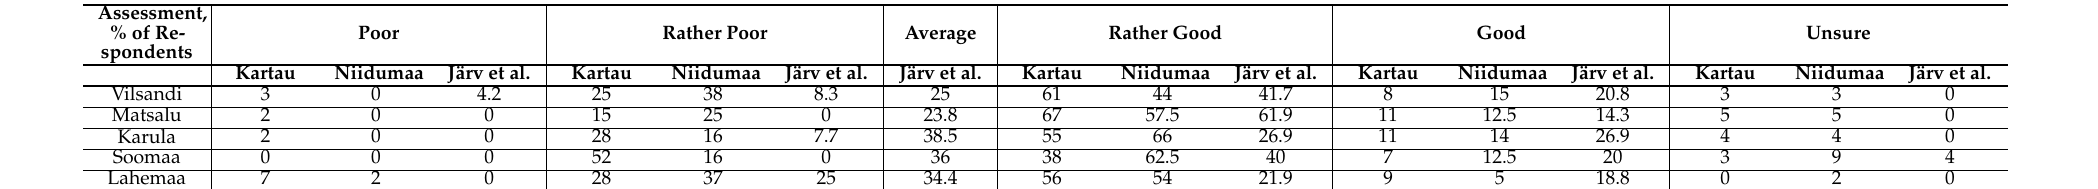
Table 2. Respondents’ awareness about rules and restrictions in force in NPs (Kartau, 1998; Niidumaa, 2009; Järv et al.,